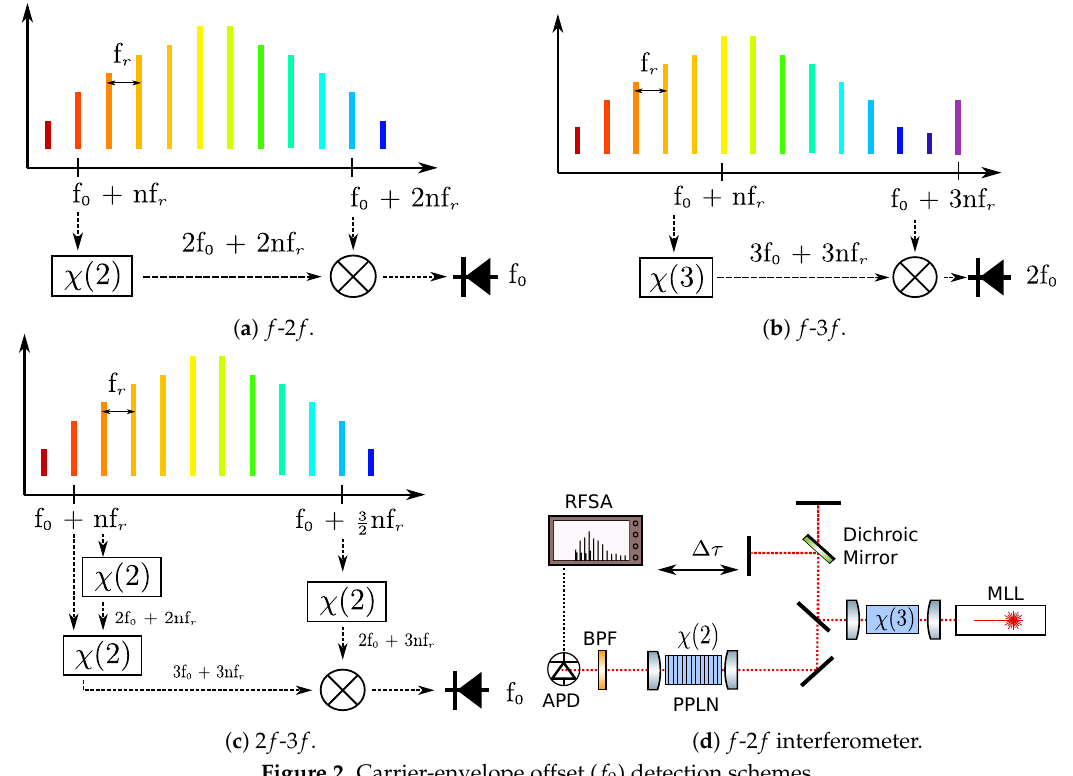
Figure 2. Carrier-envelope offset ( f 0 ) detection